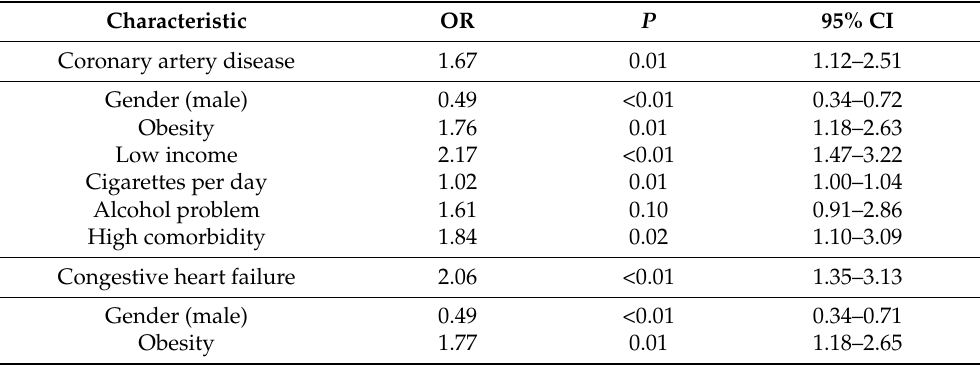
Table 4. Multivariate logistic regression of dependent variable, obstructive lung disease, vs. CAD, CHF, PVD, and